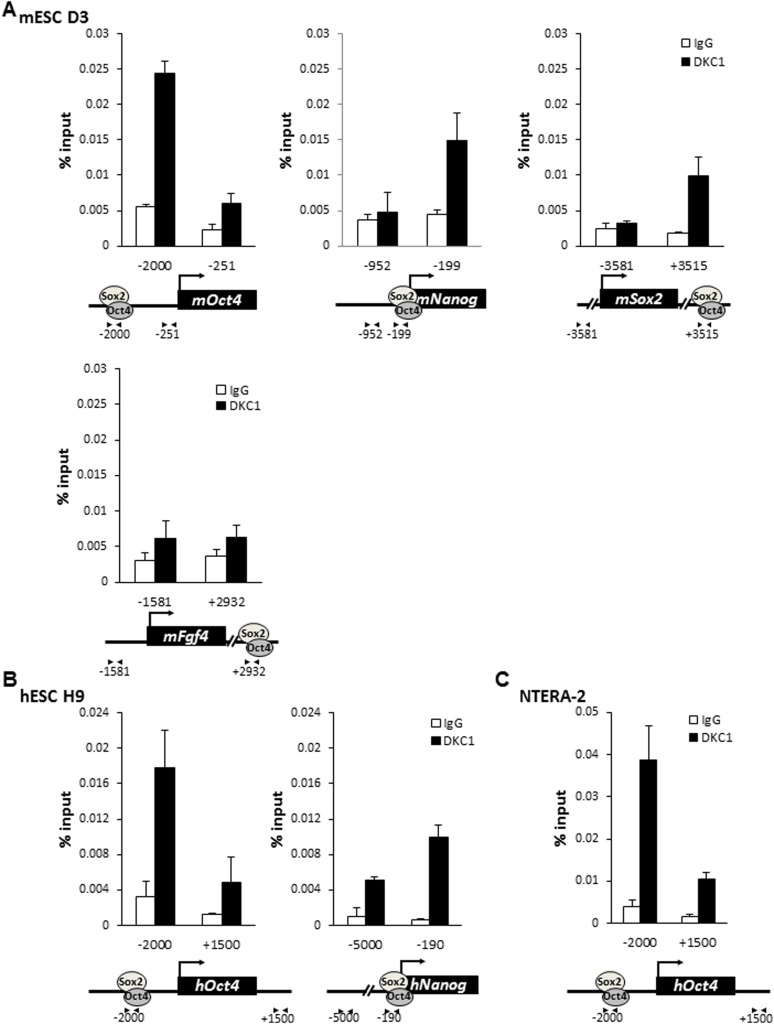
The DKC1 complex is recruited to regulatory regions of key pluripotency genes in mouse and human ES cells.(A) Co-occupancy of DKC1, OCT4, and SOX2 on enhancers of Oct4, Nanog, Sox2, but not Fgf4, in mouse ES cell line D3. Chromatin immunoprecipitation (ChIP) analysis of DKC1 occupancy on control and enhancer regions of the Oct4, Nanog, Sox2, and Fgf4 gene loci. Representative data (n = 3) showing the enrichment of DKC1 (black bars) compared to control IgGs (white bars) are analyzed by qPCR and expressed as percentage of input chromatin. Schematic diagrams of OCT4/SOX2 binding sites of each gene and the relative positions of the amplicons used to detect enriched ChIP fragments are shown at the bottom. Error bars represent standard deviation, n = 3. Primer sequences can be found in Supplementary file 1. (B) DKC1 is recruited to regulatory regions of Oct4 and Nanog in human ES cell line H9. Representative ChIP data (n = 3) are analyzed as described in (A). Error bars represent standard deviation, n = 3. (C) DKC1 is enriched on Oct4 promoter in human embryonal carcinoma cell line NT2. Representative ChIP data (n = 3) are analyzed as described in (A). Error bars represent standard deviation, n = 3.